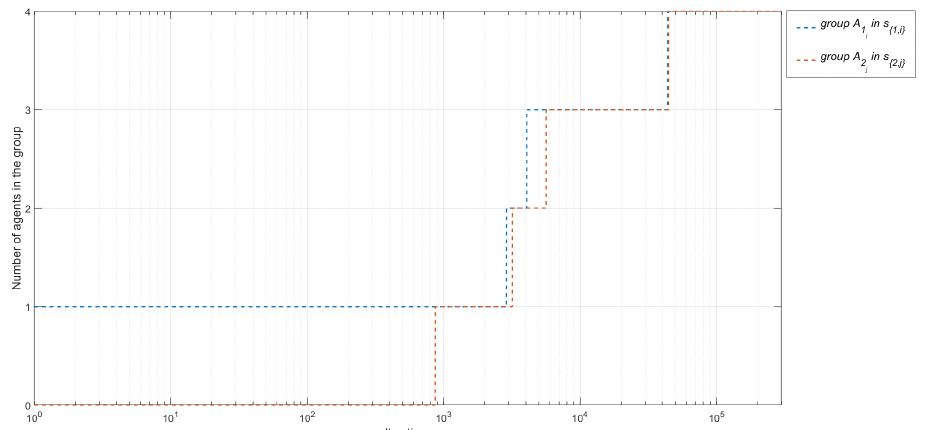
Figure 15. The exploration of heterogeneous space, simulated for 30,000 iterations: Pmax { f , k , v } = Pa { f , k , v } = Pr { f , k , v } = 400, TCa { f , k , v } = 0, TR add and Pena { j , m , i } ( t ) = Penr { j , m , i } = 3 ∗ Pmax { f , k , v }